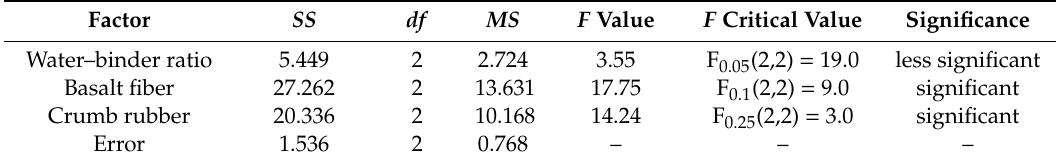
Table 9. Variance analysis for the compressive strength of CRBFC.